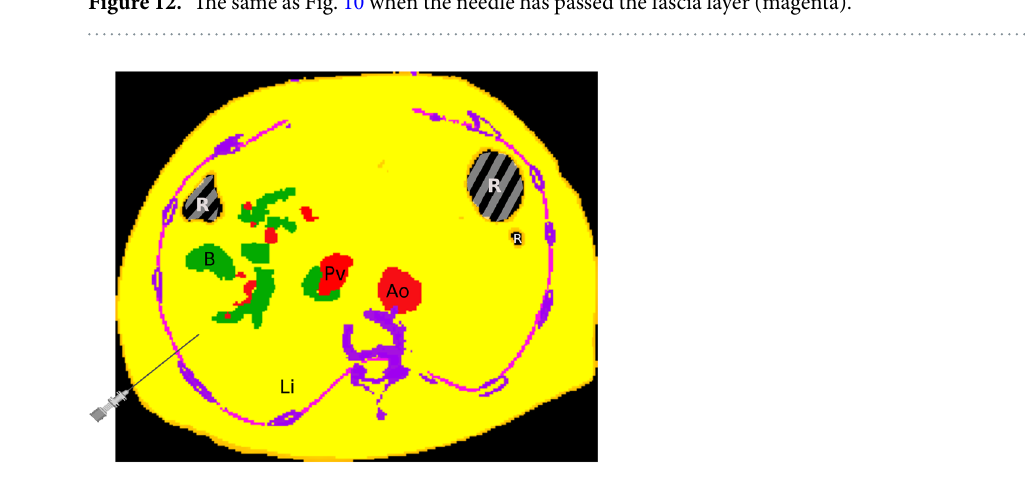
Figure 13. Applied transfer function from Fig. 12 augmented by some segmented key structures. The bile ducts are green and blood vessels